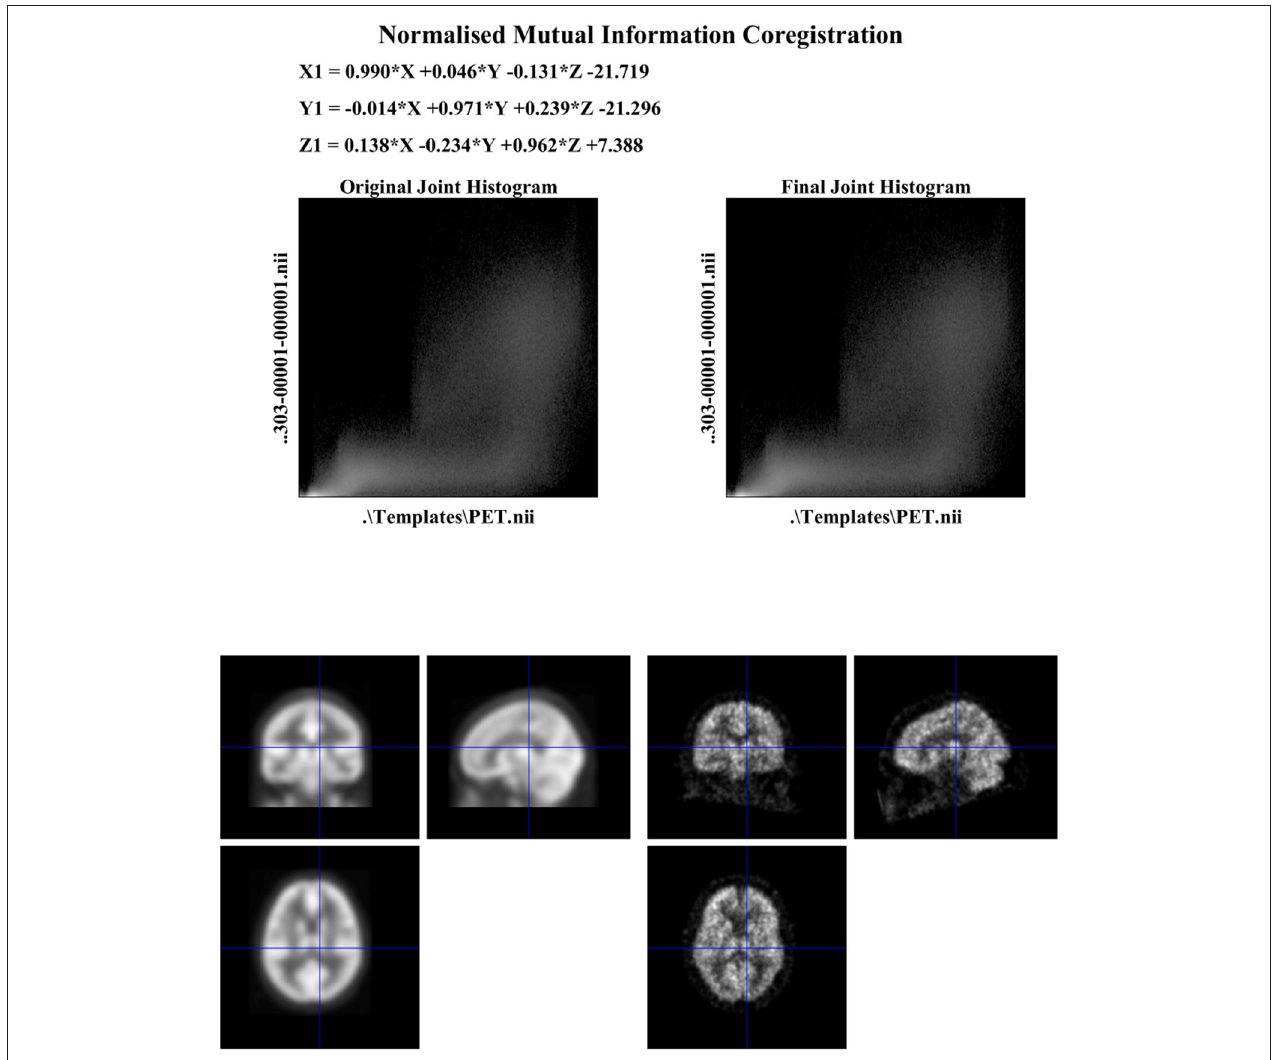
FIGURE 1 | Outcome of